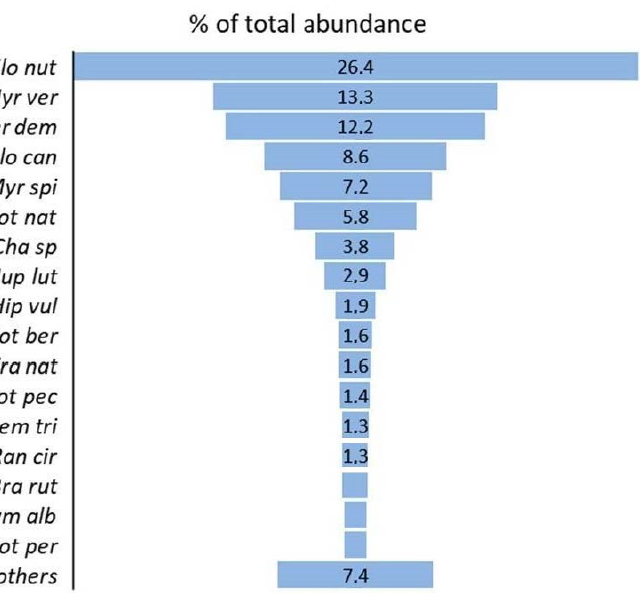
Figure 5. Ratio of total relative abundance of hydrophyte species that presented more than 1% in surveyed waterbodies: Elo nut—Elodea nuttallii , Myr ver—Myriophyllum verticillatum , Cer dem — Ceratophyllum demersum , Elo can — Elodea canadensis , Myr spi — Myriophyllum spicatum , Pot nat — Potamogeton natans , Cha sp— Chara species, Nup lut — Nuphar luteum , Hip vul—Hippuris vulgaris , Pot ber—Potamogeton bertholdii , Tra nat—Trapa natans , Pot pec—Potamogeton pectinatus , Lem tri—Lemna trisulca , Ran cir—Ranunculus circinatus , Bra rut—Brachythecium rutabulum , Nym alb—Nymphaea alba , Pot per—Potamogeton perfoliatus, others— the sum of abundances of species with less than 1%.